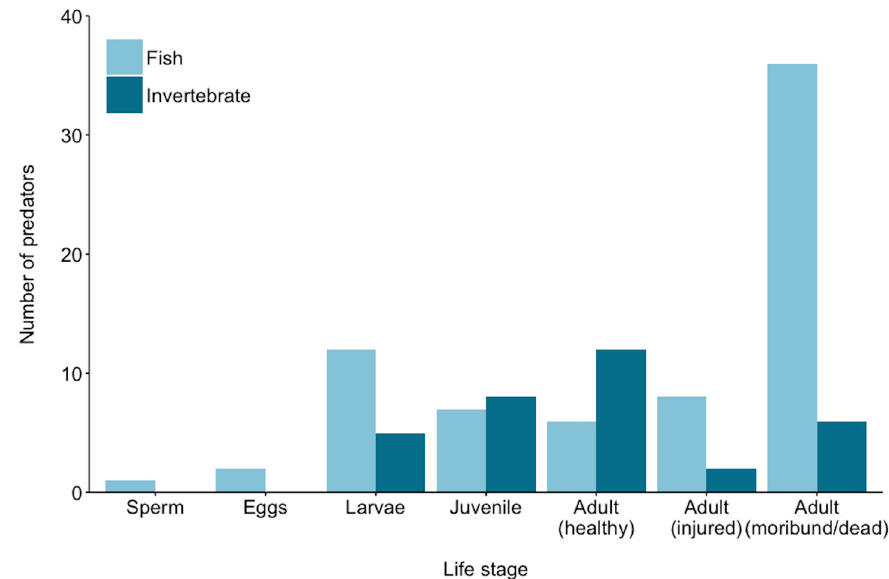
Figure 2. Putative predators of crown-of-thorns starfish across each major life stage. Predators at each life stage are not mutually exclusive. This figure is based on references from Table 1.